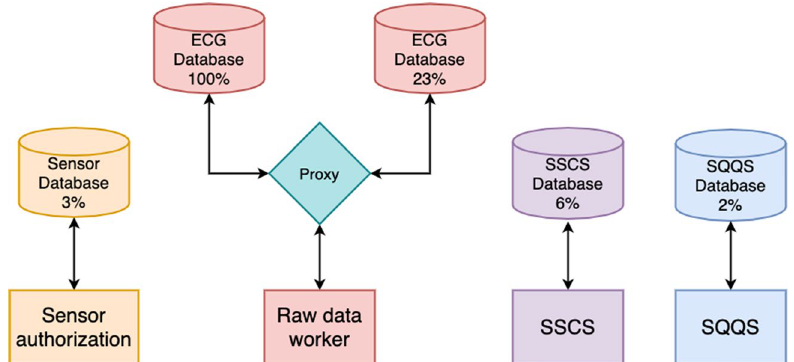
Fig. 14 Traditional system with two split